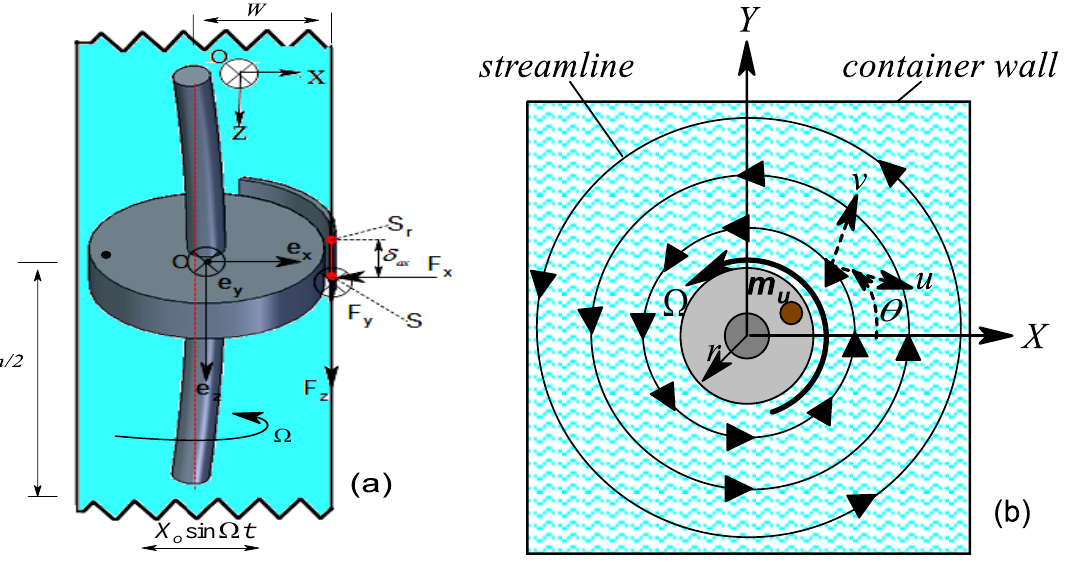
Figure 4. ( a ) Rectangular tank subject to harmonic excitation; ( b ) fluid profile around the